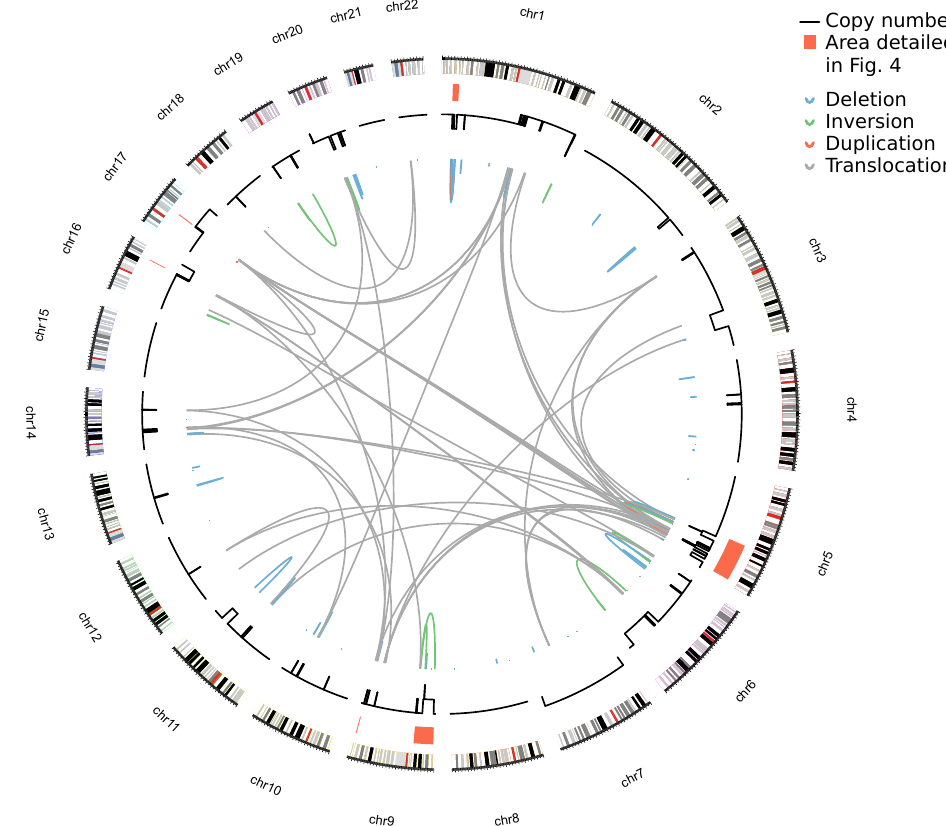
Figure 3. Structural variations in a early-stage MF sample detected by nanopore sequencing. Plotting of the copy-number landscape as derived from the WXS (black lines, outer ring) and the SVs detected by nanopore sequencing (colored lines, inner ring). Coloring of individual SVs indicates the SV class. The height of SV curves is proportional to the SV size. The areas marked in red are elucidated in Figure